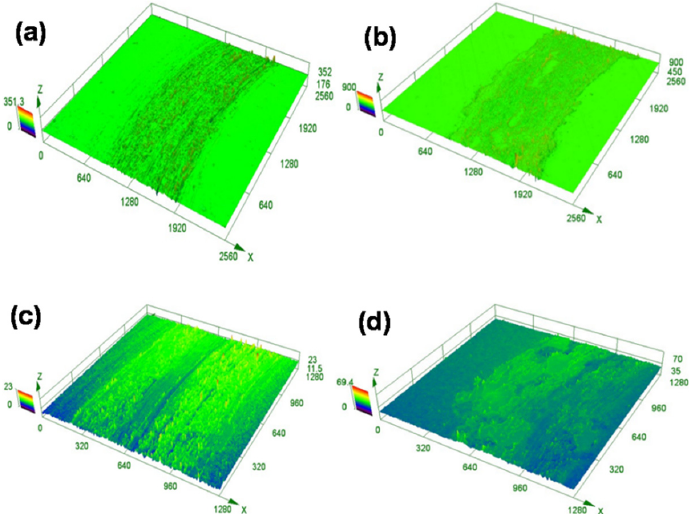
Figure 10. Three-dimensional images of the worn surface of BN coatings under different temperatures: ( a ) 500 °C, ( b ) 600 °C, ( c ) 700 °C and ( d ) 800 °C.